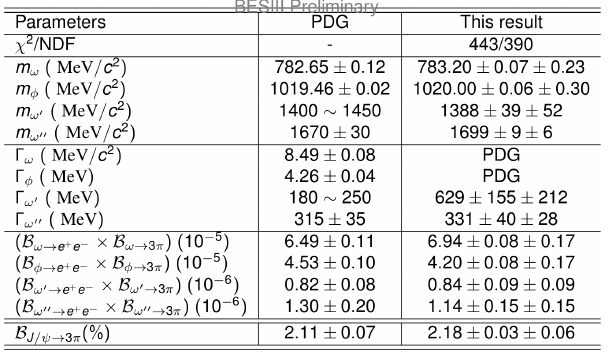
Table 2. Preliminary results on a π